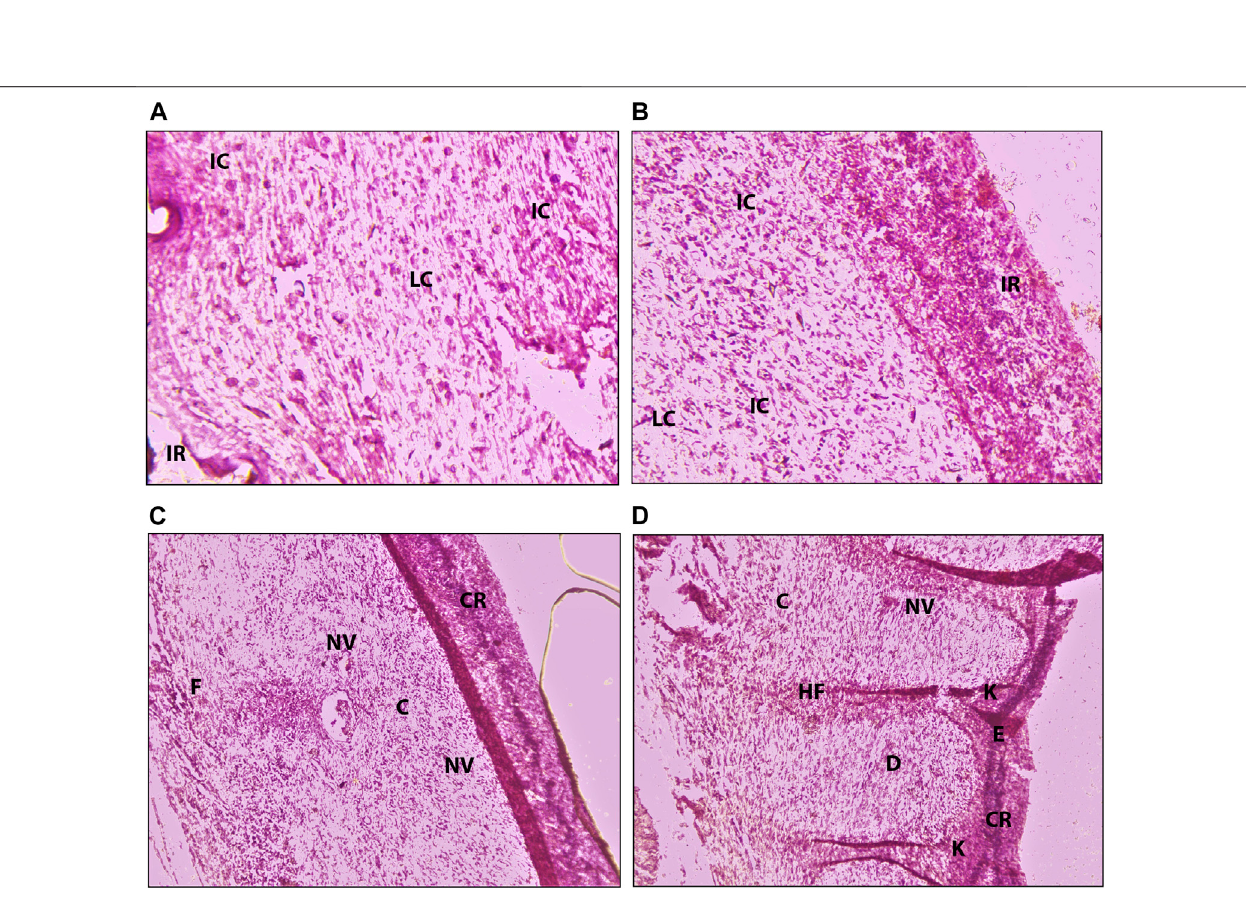
Frontiers in Pharmacology |